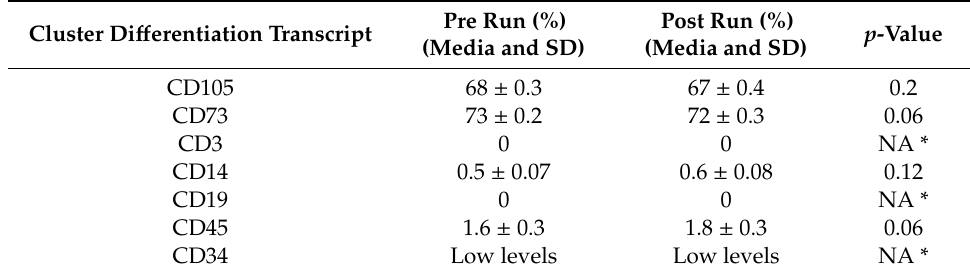
Table 1. Relative expression (in percent) of cluster di ff erentiation (CD) obtained by depletion method in PRE and POST run